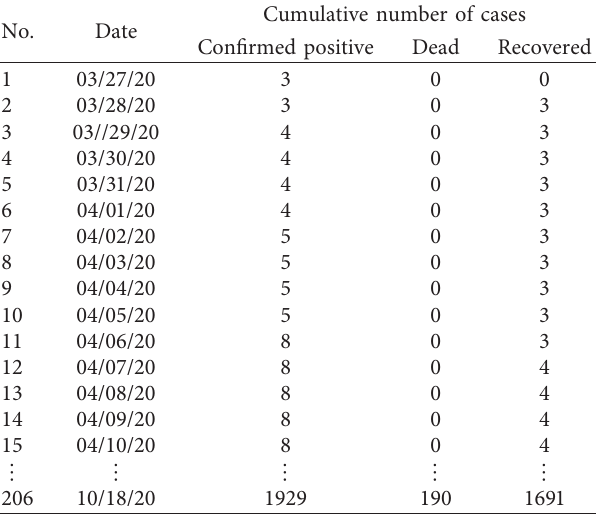
Table 1: Data of the cumulative number of COVID-19 cases in Malang City.